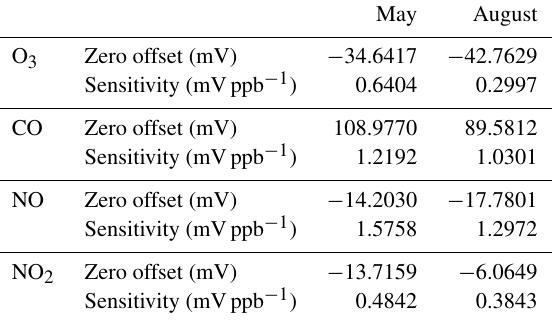
Table 1. Zero offsets and sensitivities of a representative quartet of Alphasense B4 electrochemical sensors derived via comparison to delivered reference gases during two separate laboratory calibration separated by an approximately 10-week